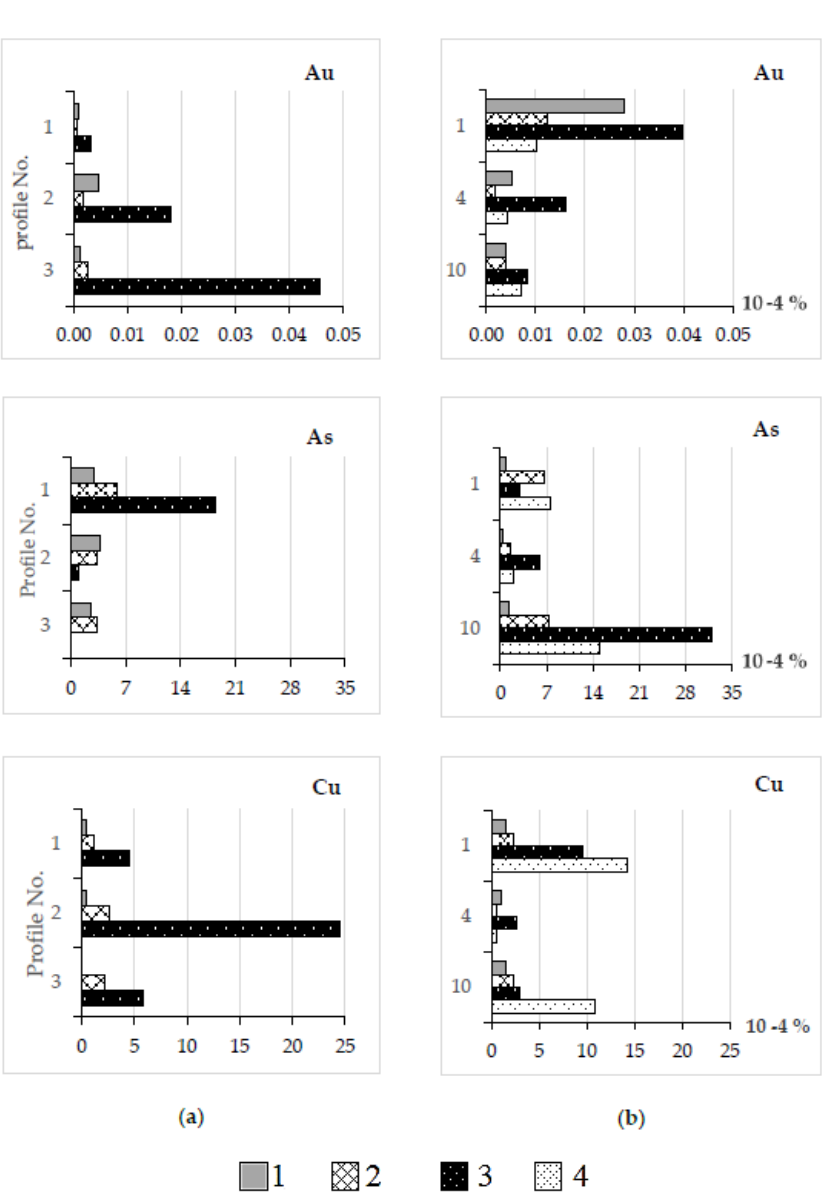
Figure 6. The ratio variation of Au, As, and Cu bound to organic matter and carbon in loose sediment horizons in the Novye Peski ( a ) and Piilola ( b ) areas. Horizons: 1—E, 2—Bf (Bhf), 3—C, 4—moraine. The highest Au/C ratio is in the C soil horizon of profile No. 3, and it does not point to the mineralized zone at Novye Peski. Arsenic and copper also have the highest ratio in the C horizon, but this is in profile No. 2 for copper and only for arsenic in profile No. 1, over the mineralized zone at Novye Peski. The highest ratios of Au, As, and Cu bound to organic matter and organic carbon are also common for the lower horizons of overburden in the Piilola prospecting area. The Au/C ratio does not point to the mineralized zone, despite the prevalence of the form of gold bound to organic matter. Perhaps, this is a consequence of gold’s interaction with various types of organic matter: humic (HA) and fulvic acids (FA), which contribute differently to gold migration and concentration [29–32]. The histograms for the elements bound preferably to HA and to FA are shown in Figure 7. The ratio of gold and HA carbon is highest in profile No. 1 in the Bf soil horizon, of silver is in the C horizon, and of nickel is in the E and C soil horizons in profile No. 3. As, Cu, and Mo have the highest ratio in C, but in profile No. 2. None of the analyzed elements have as high a ratio in the Bf horizon as gold, while most of the other elements achieve this in the C horizon, but in different soil